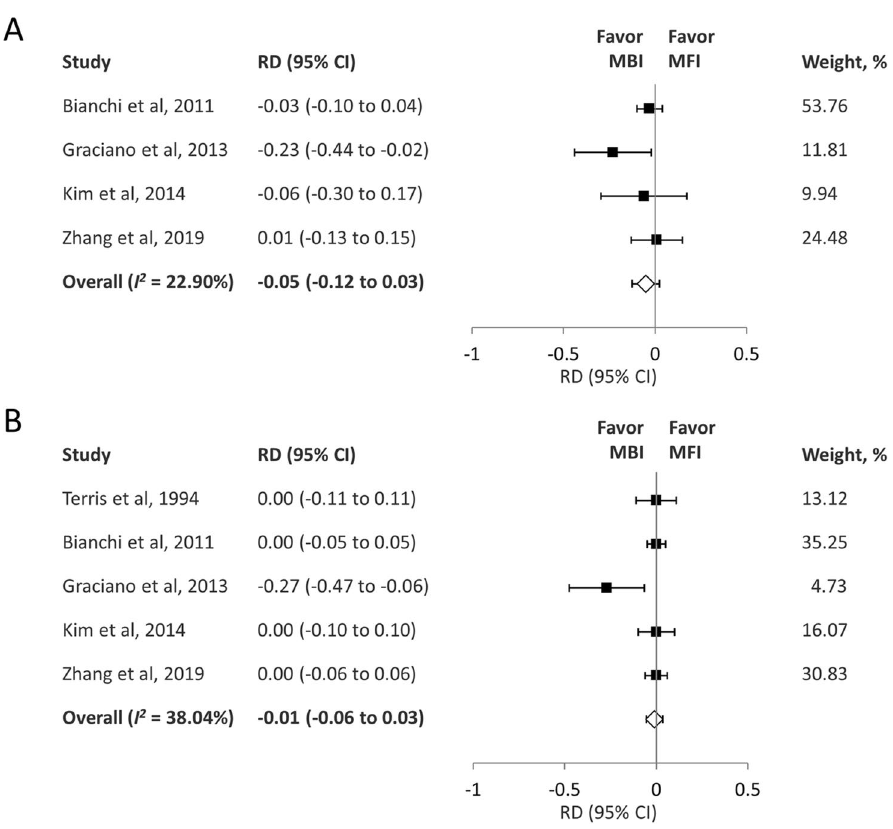
Figure 4. ( A ) Forest plot of the incidence of temporary facial palsy after parotidectomy. ( B ) Forest plot of the incidence of permanent facial palsy after parotidectomy. RD risk difference, CI confidence interval, MBI Blair incision, MFI modified facelift